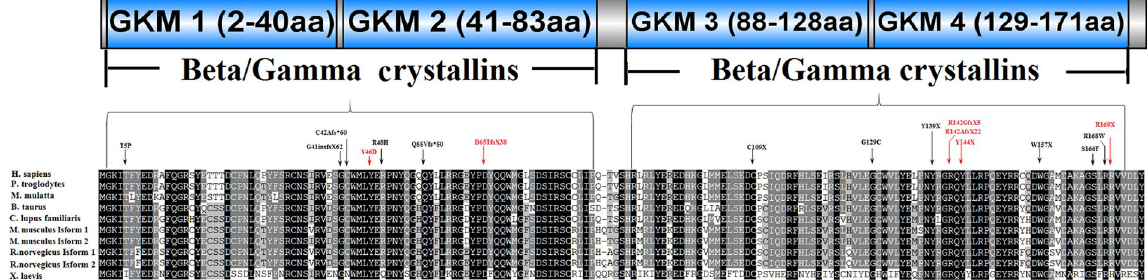
Figure 3. Schematic representation of the linear location of our identified CRYGC mutations and previously reported mutations in context of protein structure and conservation analyses of all the mutations in multiple species including human (H. sapiens), chimpanzees (P. troglodytes), monkeys (M. mulatta), cattle (B. taurus), dog (C. lupus familiaris), Norway rat (R. norvegicus), house mouse (M. musculus), and frog (X. laevis). Completely conserved residues across all species aligned were shaded with black. Previous reported mutations are pointed by black arrow and in black words. Our novel mutations are pointed by red arrow and in red